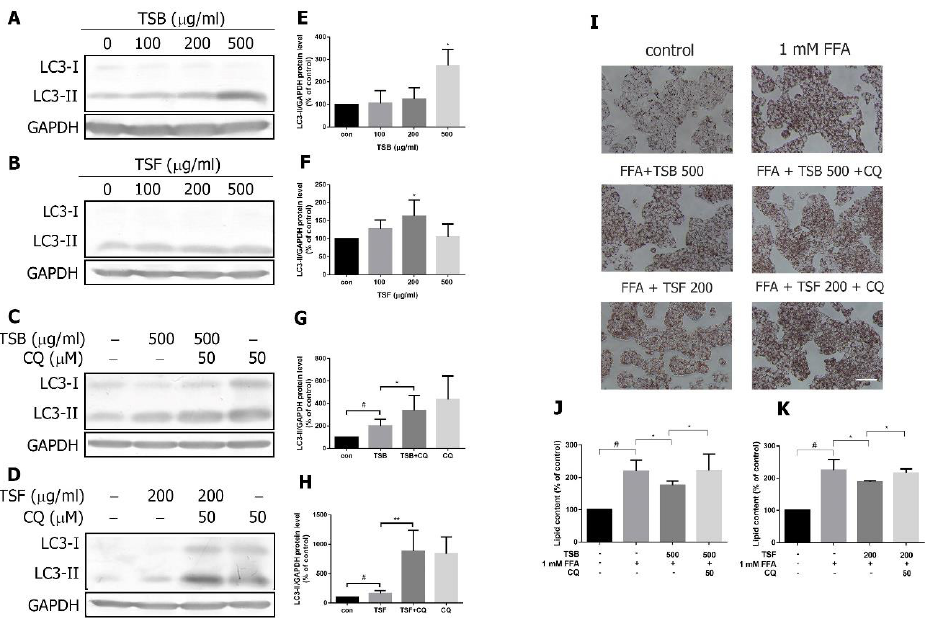
Figure 9. Effects of TSB and TSF on autophagic flux in HepG2 cells. ( A – D ) Immunoblots of LC3 subunits. ( E – H ) The bar graphs show densitometric data (mean ± SD) from three to five independent experiments. ( I ) Oil Red O staining. ( J and K ) Quantification of lipid contents. # P < 0.05 compared with the control group (con). * P < 0.05 and ** P < 0.01 compared with the FFA group. Scale bar = 50 µ